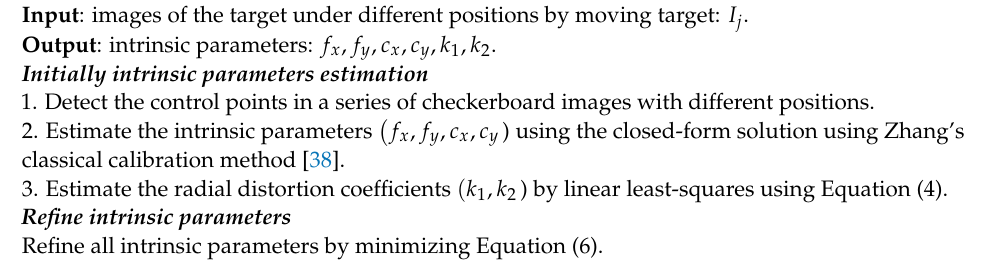
Algorithm 1. Determining intrinsic parameters from planar calibration